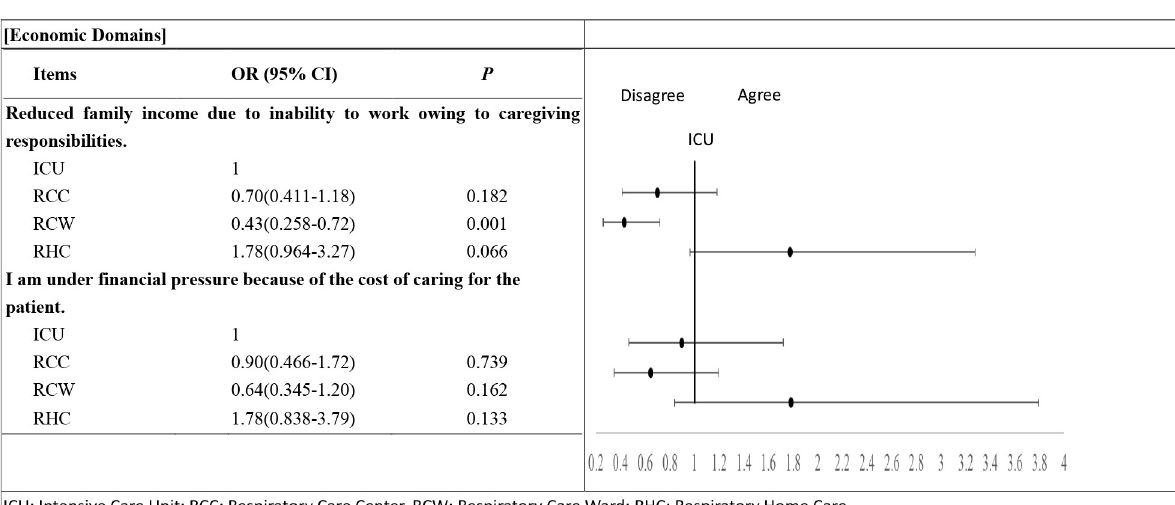
Fig 3. Odds of agreement in the life impact of the caregivers of PMV patients at various stages at economic domain.